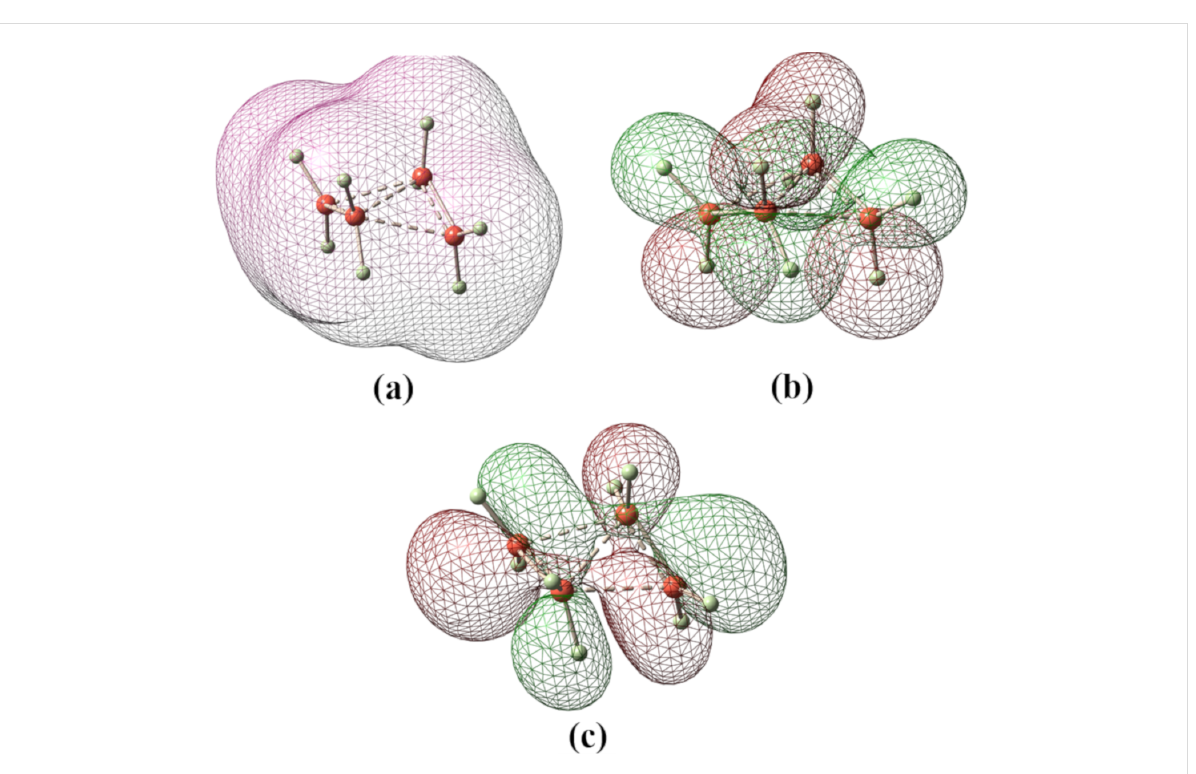
Figure 2: (a) Total electron density, (b) HOMO and (c) LUMO of the dication 1 ; coefficients are calculated at the HF/6-31G*